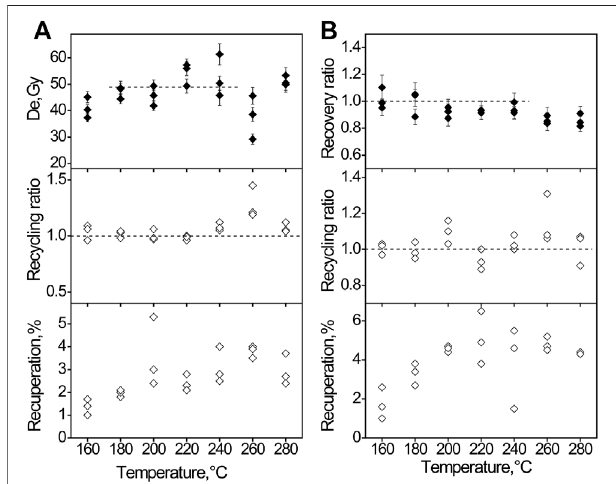
FIGURE 6 | The results of preheat plateau tests (A) and dose recovery tests (B) for sample